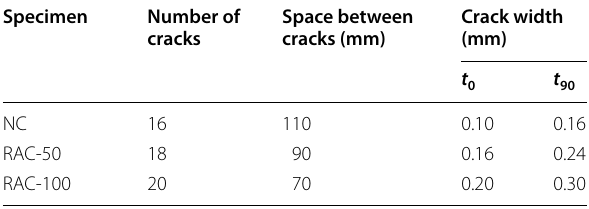
Table 4 Details of cracks during stabilised cracking